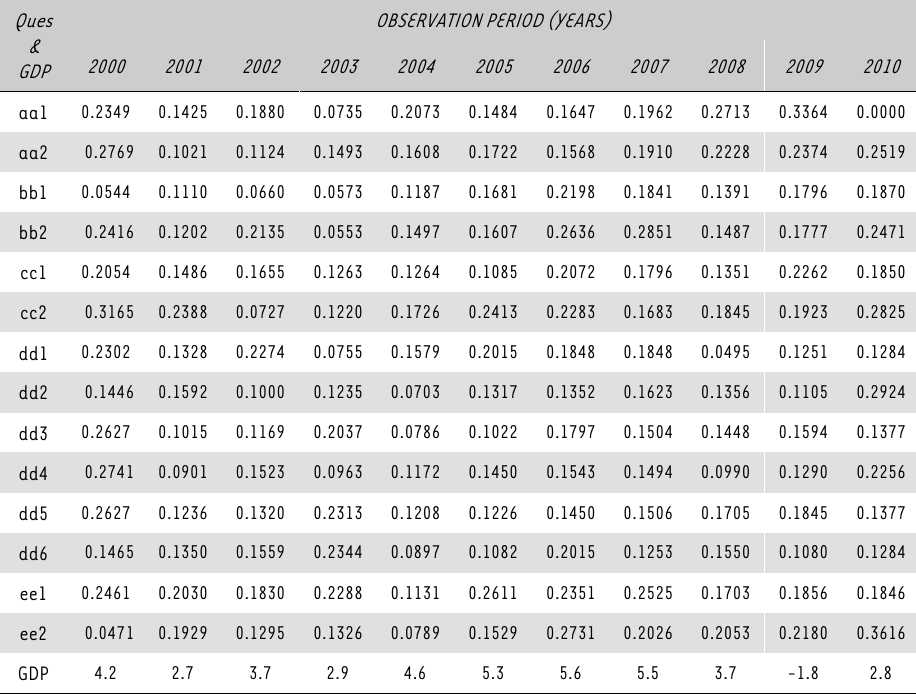
Results of Cramer’s V test for Questions aa1 to ee2 and GDP (year-on-year